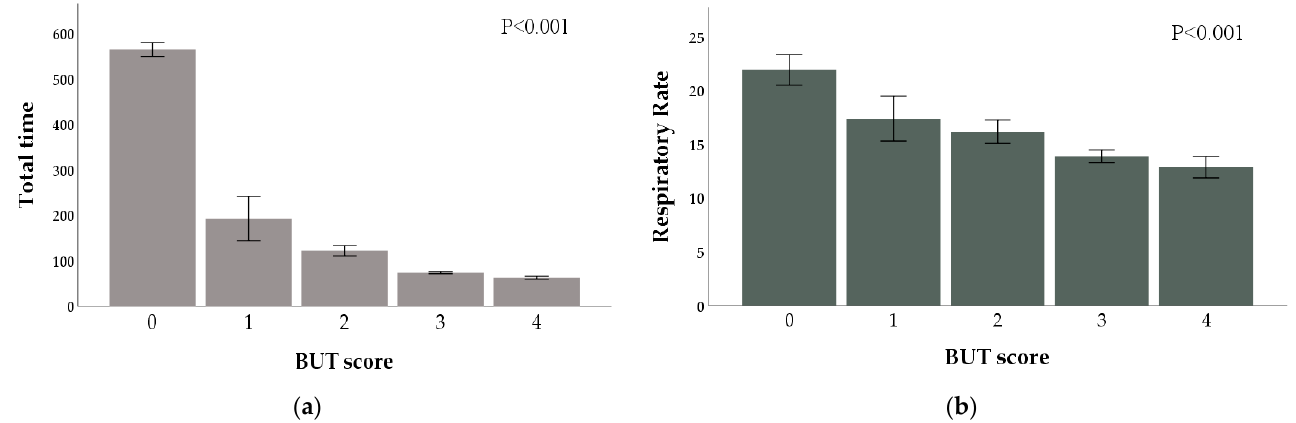
Figure 4. Means and standard errors of Total time (sec) ( a ) and Respiratory rate (bpm) ( b ) by BUT score. Ordinal logistic regression showed that, as Total time and Respiratory rate decrease, the probability of a higher BUT score increases ( p < 0.001).